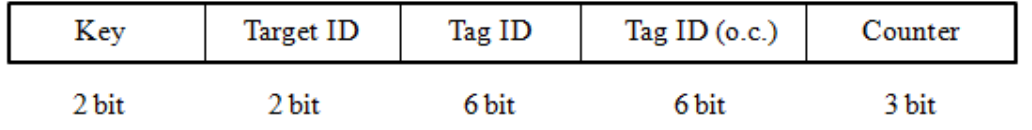
Figure 2. RFID tag’s signal general format.